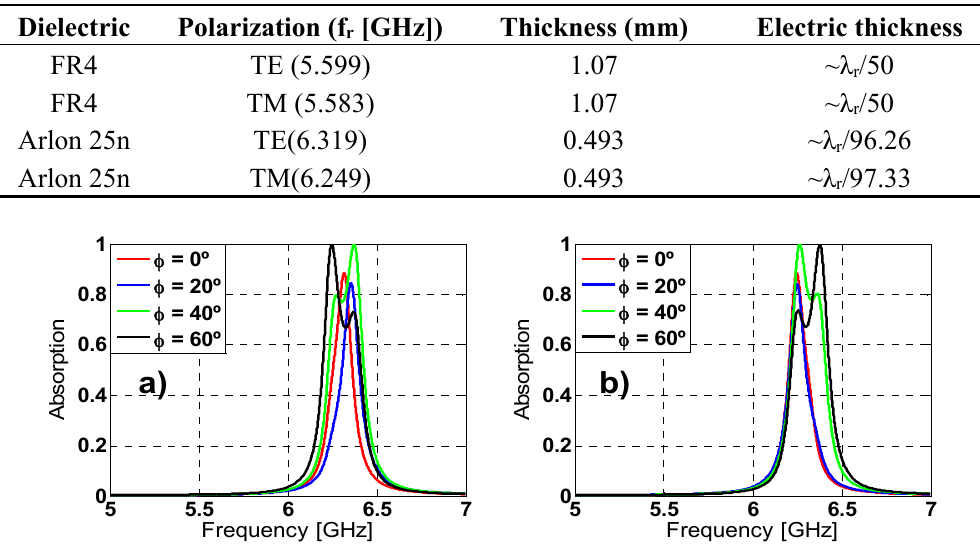
Figure 9. Absorption simulation results for different polarization angles ( ϕ ) of the incident field for both ( a ) TE and ( b ) TM polarizations.